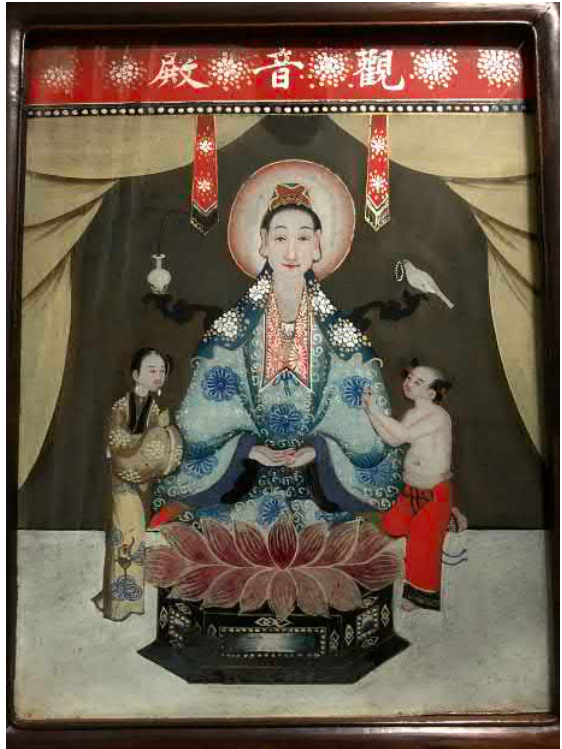
Figure 6: Kuan Yin image, Cairns and District Chinese Association. (Photo: Anna Halafoff)